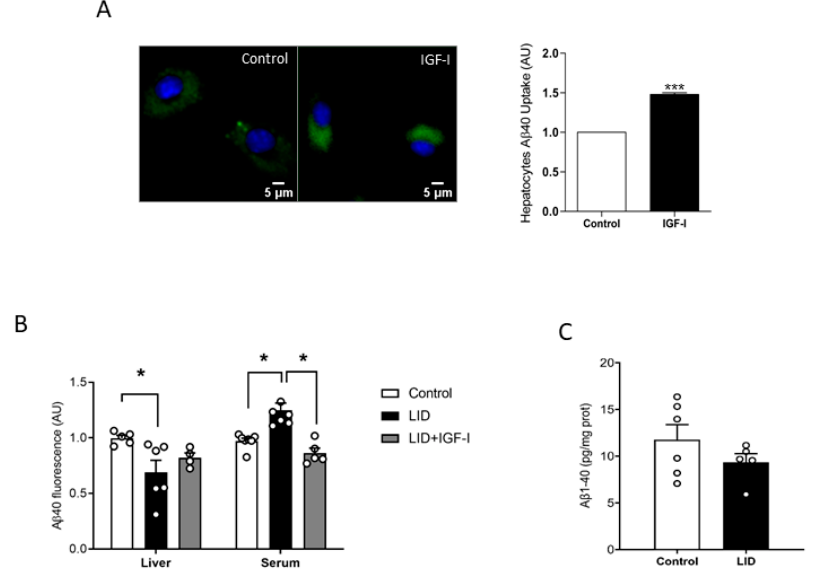
Figure 2. Modulation by IGF-I of A β uptake by hepatocytes. ( A ) IGF-I induces uptake of A β by hepatocytes ( n = 6). Representative micrograph of cultured hepatocytes with internalized fluorescent A β (green). Cell nuclei stained with Hoescht. Lower histograms: Quantification of intracellular fluorescent A β after IGF-I treatment. ( B ) Serum IGF-I deficient mice (liver IGF-I deficient (LID) mice) show reduced A β uptake by the liver, which was ameliorated by systemic IGF-I treatment ( n = 5 control / 6 LID / 5 LID + IGF-I). ( C ) Brain A β levels did not change in LID mice ( n = 8). * p < 0.05 and *** p < 0.001 .